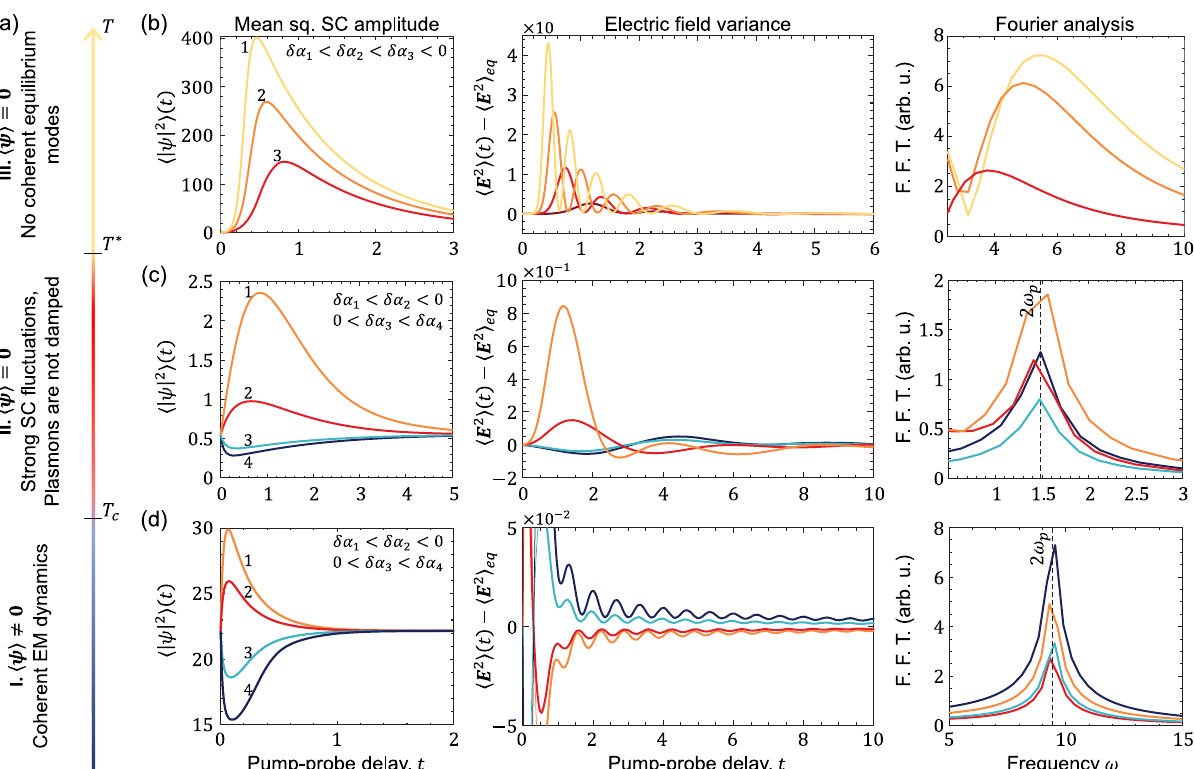
Fig. 3 Post-pulse dynamics in isotropic superconductors. a Schematic phase diagram. Depending on model parameters, there exist three regimes: (i) for T ≤ T c , the long-range order parameter expectation value is non-zero 〈 ψ 〉 ≠ 0, the plasmon gap is notable, and plasmon dynamics is coherent; (ii) T T ≤ T *, no long-range order is present 〈 ψ 〉 = 0, but superconducting equilibrium fl uctuations, as captured by 〈 ∣ ψ ∣ 2 〉 , are suf fi ciently strong, and the c < correlation length is suf fi ciently long so that plasmons are still essentially coherent excitations; (iii) T * < T , plasmons become overdamped. Quenches in I are shown in panels ( d ): the order parameter evolution (left), encoded in 〈 ∣ ψ ∣ 2 〉 ( t ), looks overdamped; in contrast, for t ≳ 1, we fi nd that the electromagnetic fi eld, as captured by h E 2 ið t Þ (cid:3) h E 2 i eq , shows periodic dynamics (middle). The frequency of the oscillations, regardless of photosuppression or photostimulation of superconductivity, equals twice the plasmon equilibrium frequency 2 ω p , as shown in the right panel, where we performed the fast Fourier transform (F.F.T.) of the tails of the curves in the middle panel, with an exponential fi t subtracted. The stronger the photoexcitation, the larger the amplitude of oscillations. Quenches in II are shown in panels ( c ). The post-pulse evolution here is similar to quenches in I, since plasmons still represent coherent excitations in equilibrium due to the strong superconducting fl uctuations. b Interestingly, provided the order parameter relaxation rate is small, one can get periodic dynamics in III via strong photostimulation of superconductivity: the post-pulse dynamics of the electromagnetic fi eld displays oscillations, though with poorly de fi ned frequency. This is because 〈 ∣ ψ ∣ 2 〉 ( t ), the quantity that de fi nes the plasmon frequency, is changing in time. Besides this, the quasiparticle conductivity is large, which makes the oscillations to be damped, cf. Eq. (11). Parameters used: τ = 100, τ E = 5, τ α = 1, χ − 1 = 0.1, κ = 5, σ = 1, Tr = 10 − 2 ( b ); τ = 5, τ E = 1, τ α = 1, χ − 1 = 0.1, κ = 5, σ = 0.1, Tr = 10 − 2 ( c ); τ = 1, τ E = 1, τ α = 0.2, χ − 1 = 0.1, κ = 25, σ = 0.1, Tr = 10 − 2 ( d ) — 0 0 0